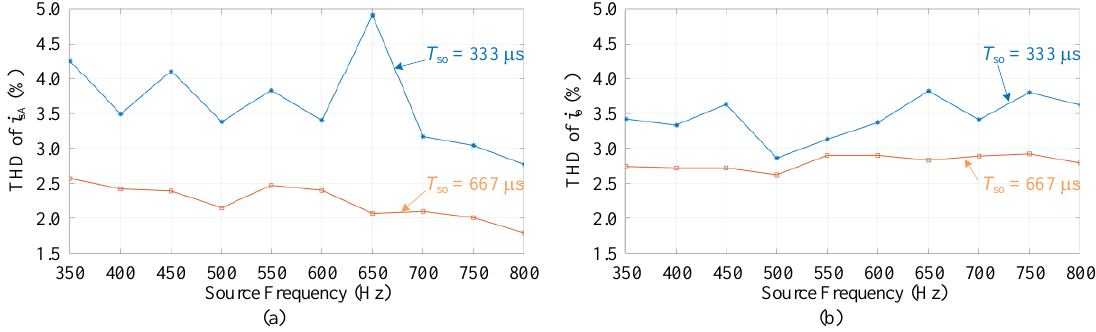
Figure 8. Total harmonic distortions (THDs) of source current i sA and output current i o when the source frequency varies between 350 Hz and 800 Hz: ( a ) THD of i sA and ( b ) THD of i o .